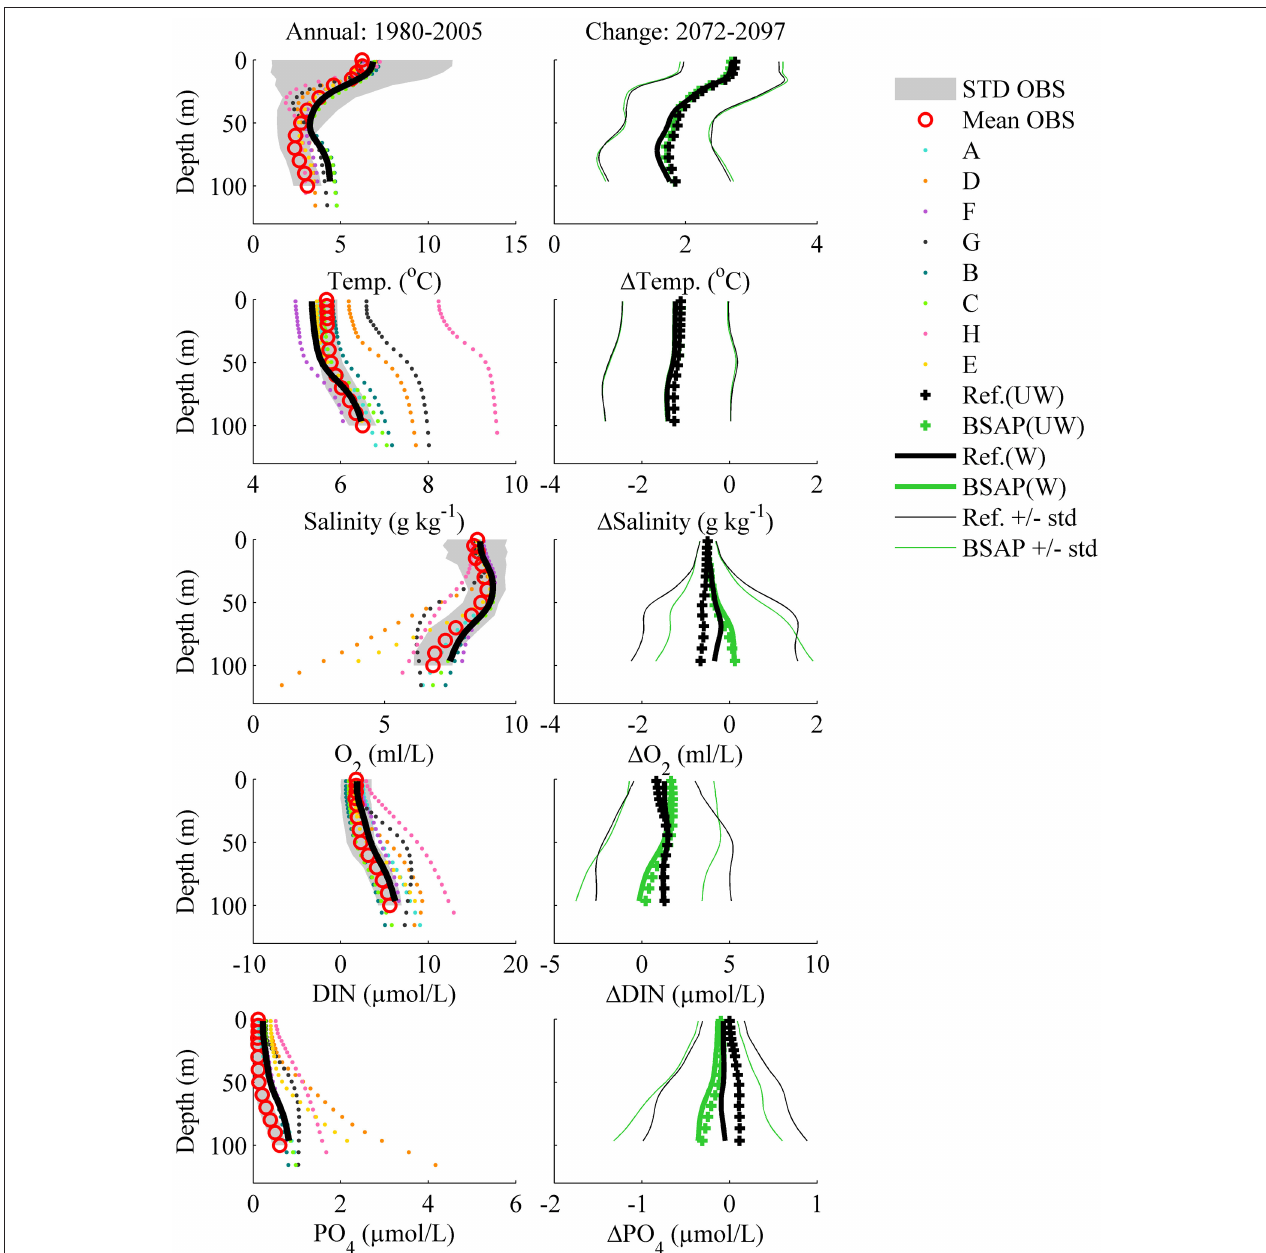
FIGURE 12 | Mean observed and simulated profiles in the control runs for each variable and each Model A to H at SR5 in the Bothnian Sea for the period 1980–2005 (left panels). The ensemble mean value (thick black line) is calculated from the weighted model results. In addition, the unweighted (plus signs) and weighted (thick solid lines) ensemble mean changes and standard deviations between the future (2072–2097) and present (1980–2005) climates in REF and BSAP scenario simulations are shown (right panels). Standard deviations are calculated from the two ensembles without